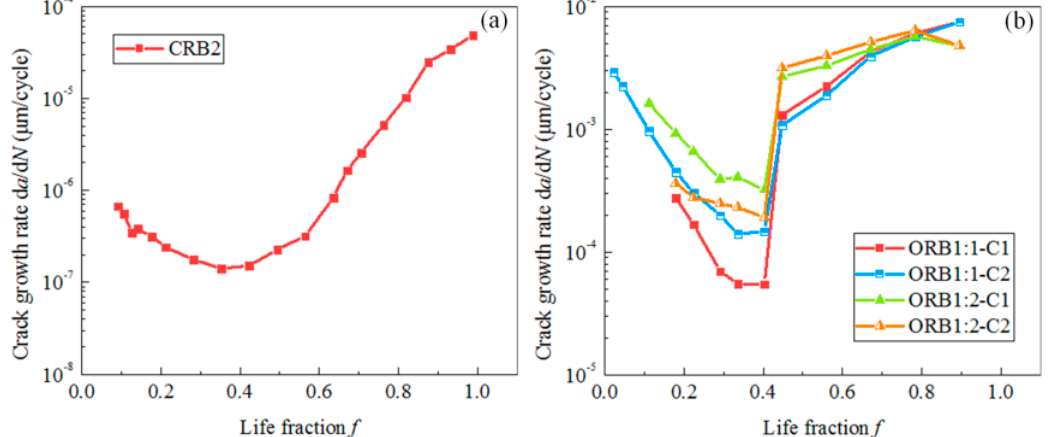
Figure 10. Curves showing crack growth rate as a function of life fraction: ( a ) CRB2; ( b ) ORB1.